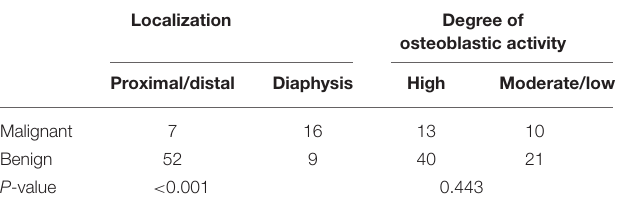
TABLE 4 | The relation between localization/degree of osteoblastic activity and final diagnosis of extremity lesions. Localization Degree of osteoblastic